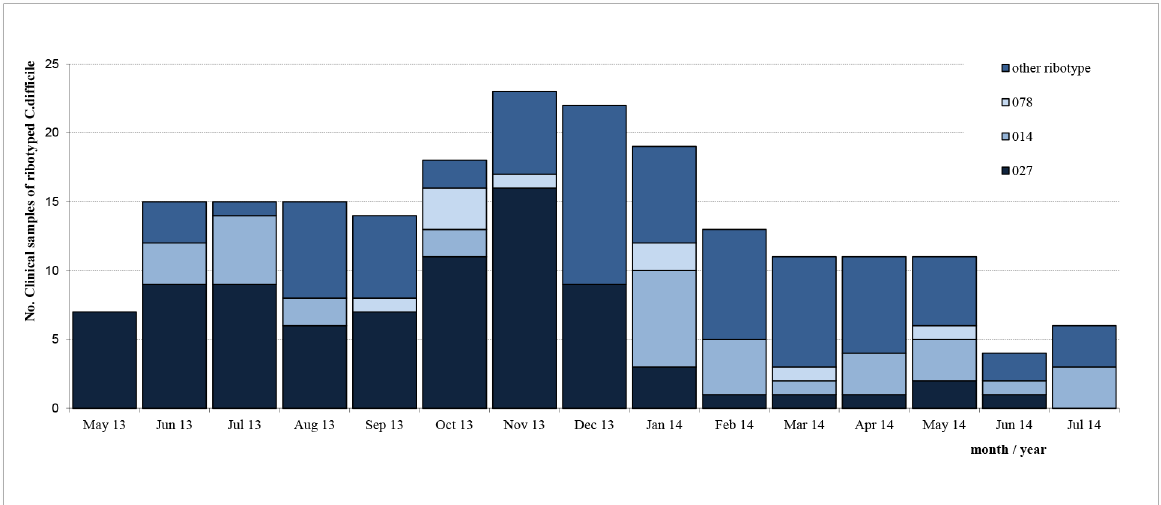
Fig 2. Monthly incidence of C . difficile infection from May 2013 to July